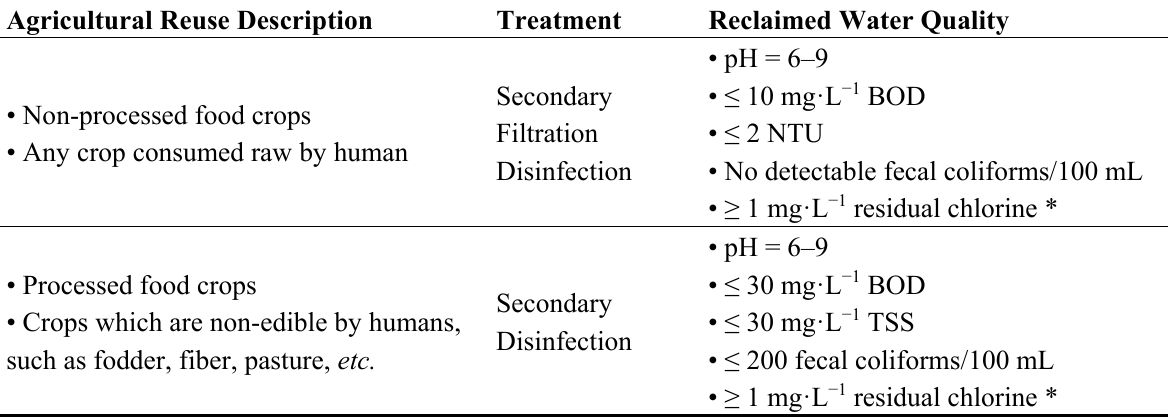
Table 3. Summary of U.S. EPA guidelines for water reuse for agricultural irrigation